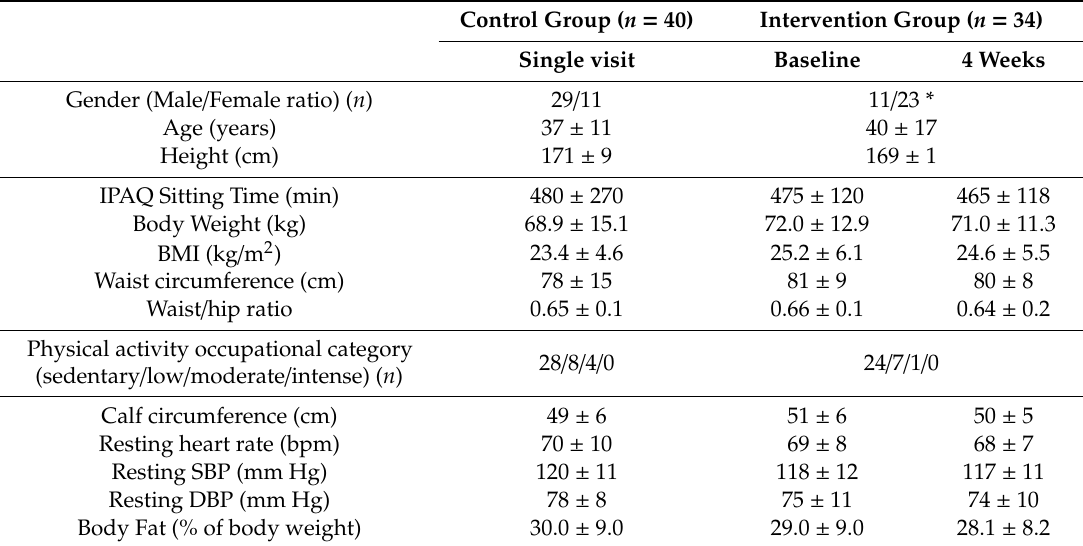
Table 1. Baseline characteristics of